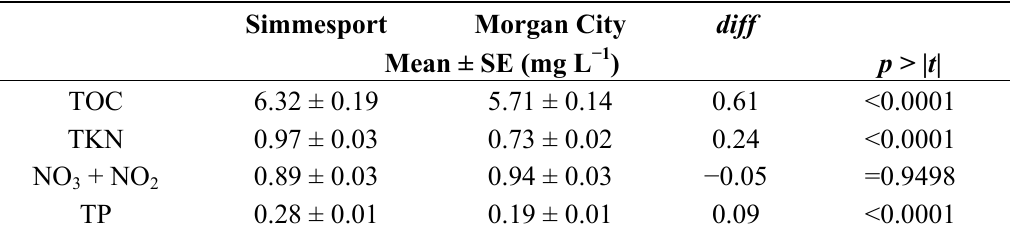
Table 2. Average concentrations of total organic carbon (TOC), total Kjeldahl nitrogen (TKN), nitrate and nitrite nitrogen (NO upstream (Simmesport) and downstream (Morgan City)